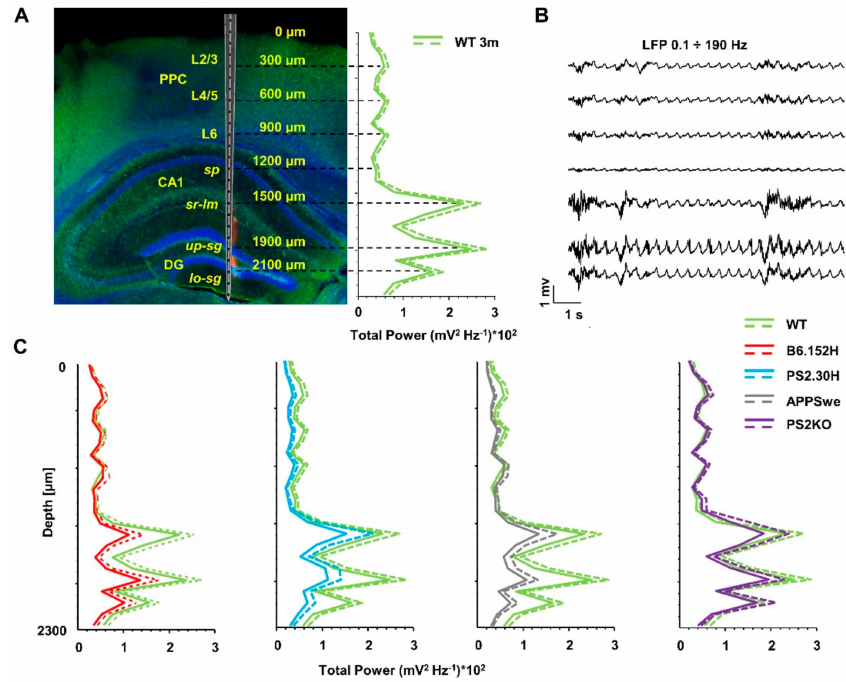
Figure 2. Simultaneous recording of LFP signals from PPC and dorsal HPF. ( A ) Left panel : Coronal brain section (70 µ m) from a three-month-old WT mouse visualized by Hoechst-33342 (blue), DiI (red) and bright field (green) signals. The image also shows a schematic drawing of the linear probe, the total power profile recorded by the 24 channels (mean + SEM), and the depths of the seven channels used for analysis. ( B ) Representative band-pass (0.1–190 Hz) filtered LFP recordings from the selected channels. ( C ) Average total power profile at three months of each tg line compared to that of age-matched WT mice (mean +